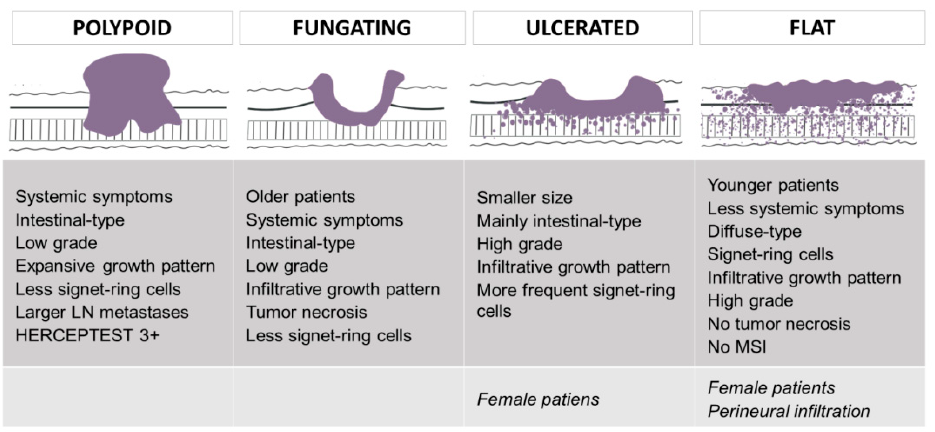
Table 3. Univariate analysis. Features significantly related to tumor recurrence and death.